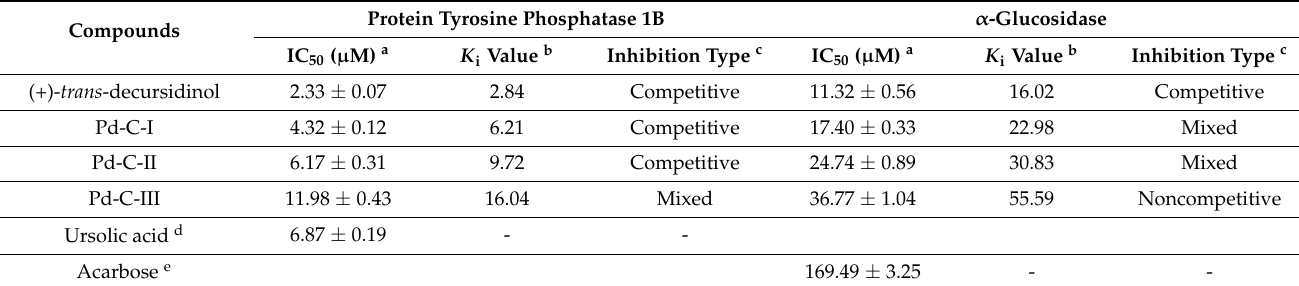
Figure 1. Chemical structure of the isolated dihydroxanthyletin-type coumarins from Angelica decursiva. Table 1. Protein tyrosine phosphatase 1B (PTP1B) and α -glucosidase inhibitory activities of dihydroxanthyletin-type coumarins from Angelica decursiva.